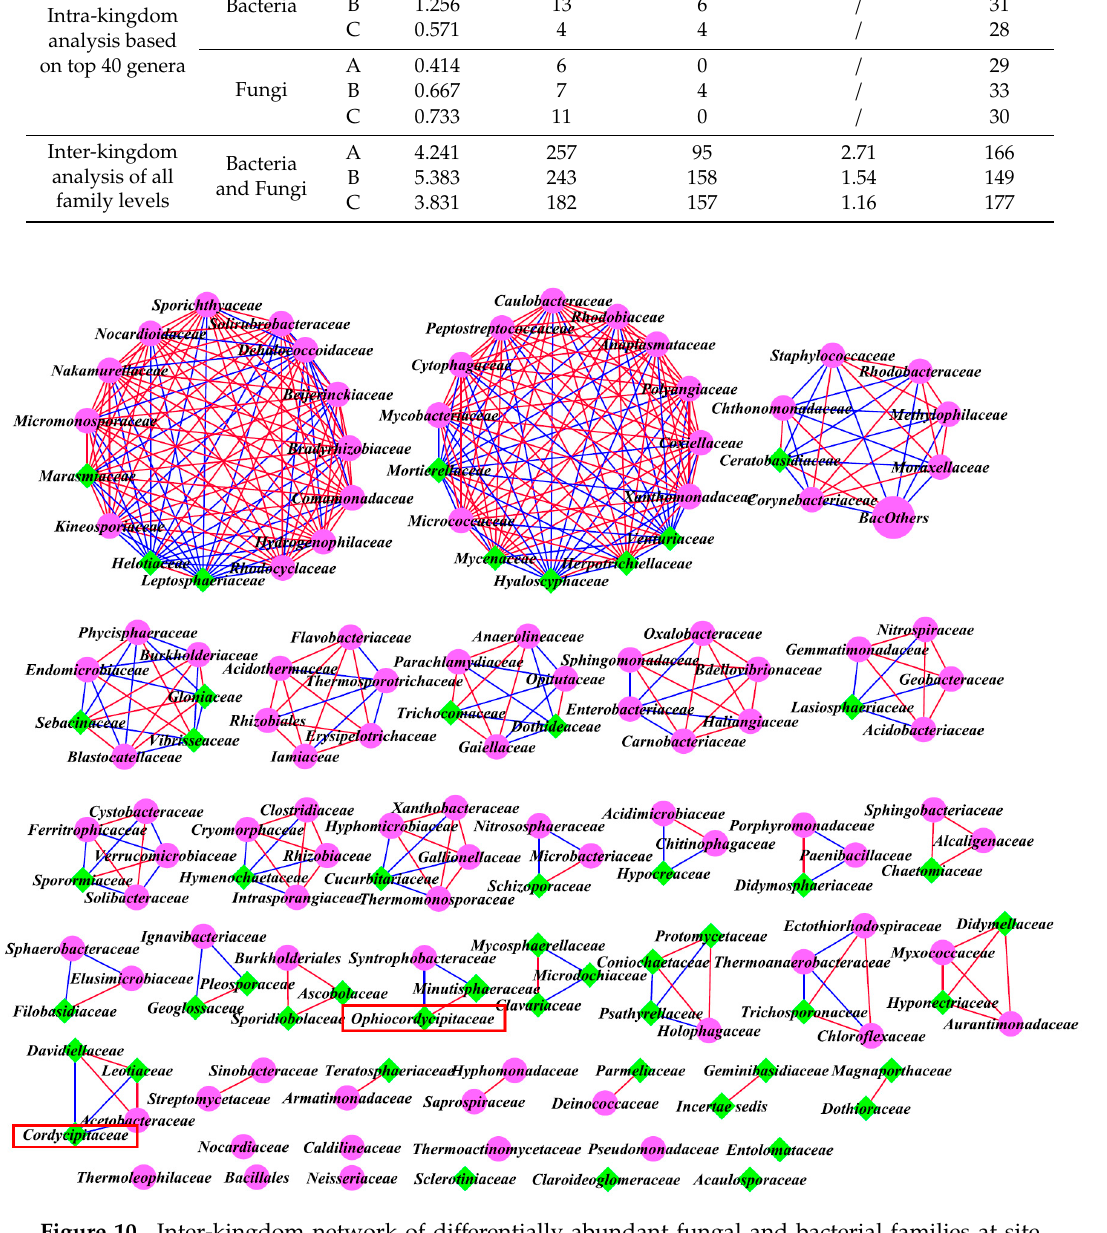
Figure 10. Inter-kingdom network of differentially abundant fungal and bacterial families at site B. Highly significant positive ( R > 0.80, FDR < 0.05) and negative ( R < − 0.80, FDR < 0.05) Pearson correlations are represented by red and blue lines. The size of each node is proportional to the degree. Fuchsia circles: bacterial kingdoms, green diamonds: fungal kingdoms, red rectangle highlights Cordyceps -related family.